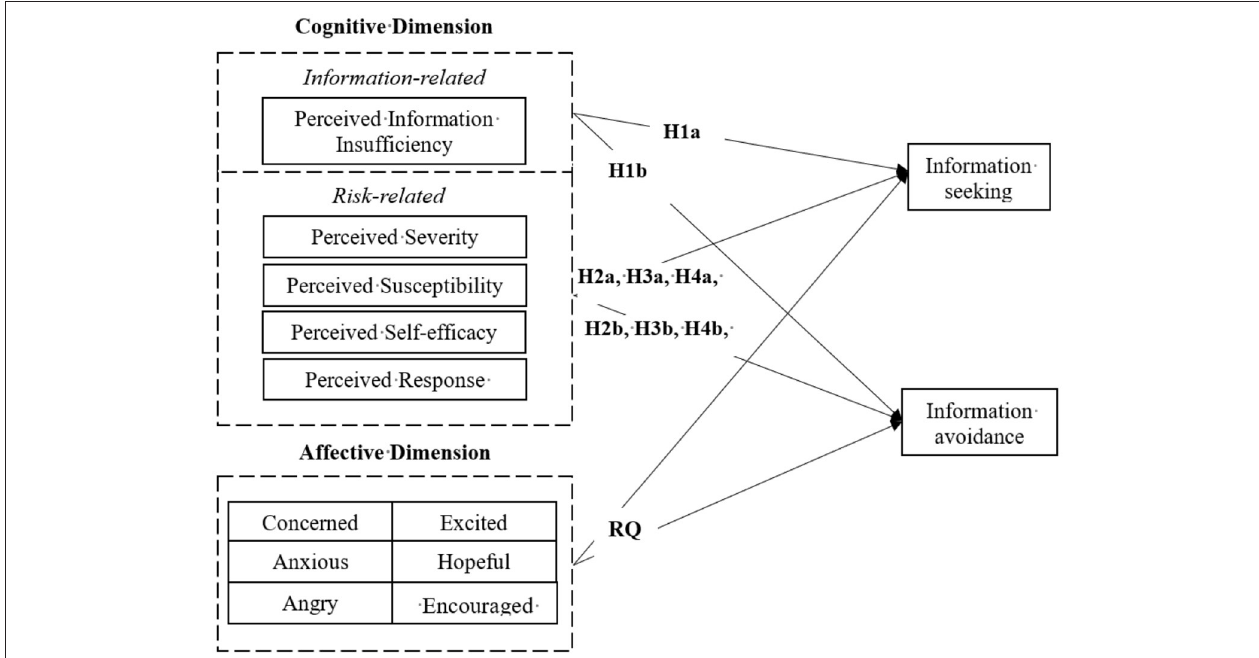
FIGURE 1 | The cognitive and affective predictors on information-seeking and information-avoidance behaviour.